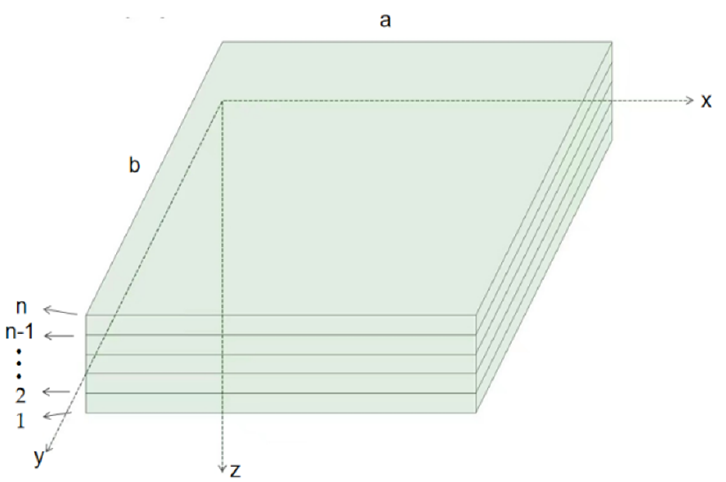
Figure 3. Configuration of a multi-layer plate model. For different distribution patterns, the volume content V GPL was the graphene changes along the thickness